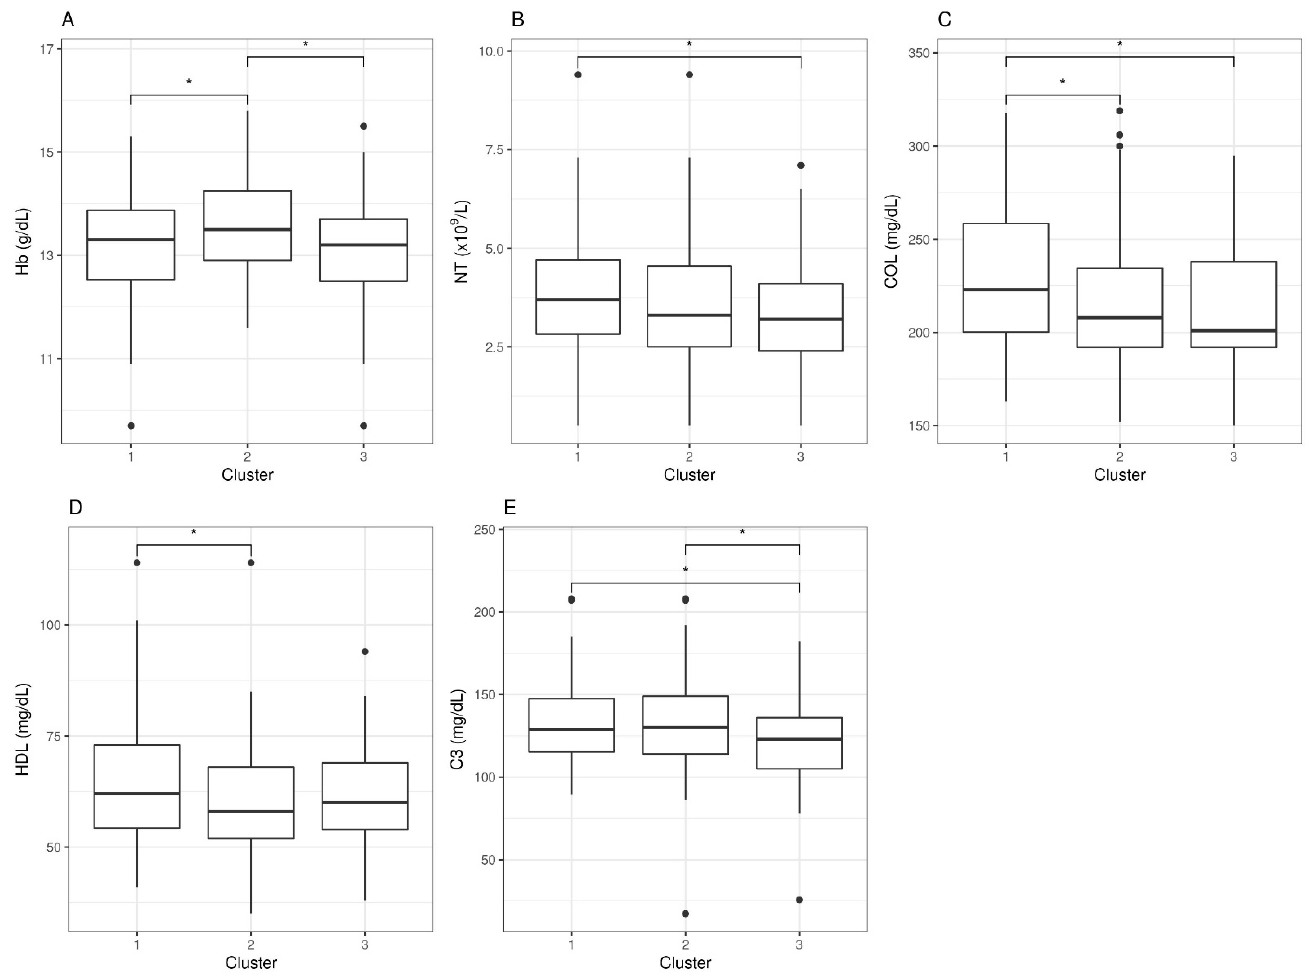
Figure 2. Blood analytic difference boxplots between ME/CFS symptom-based clusters. Abbreviations: Hb, hemoglobin; NT, neutrophil counts; COL, cholesterol; HDL, high-density lipoprotein; C3, complement 3. The significance level was set at * p < 0.05. Data beyond 1.5 inter-quartile range values, representing potential outliers, are plotted as individual dots.